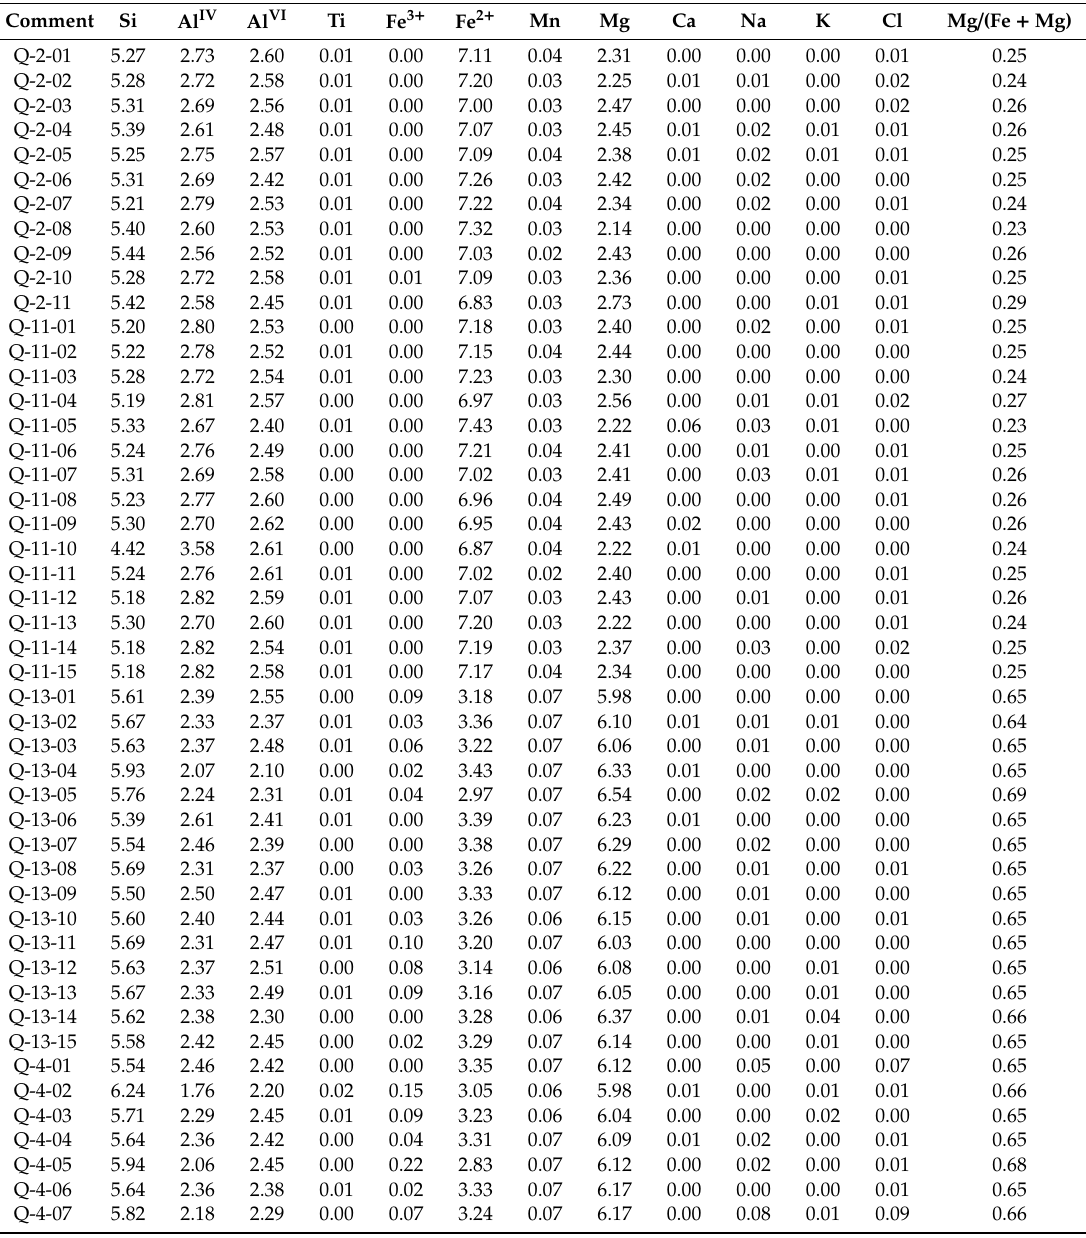
Table 2. Calculation of the chlorite structural formula (based on 28 oxygen